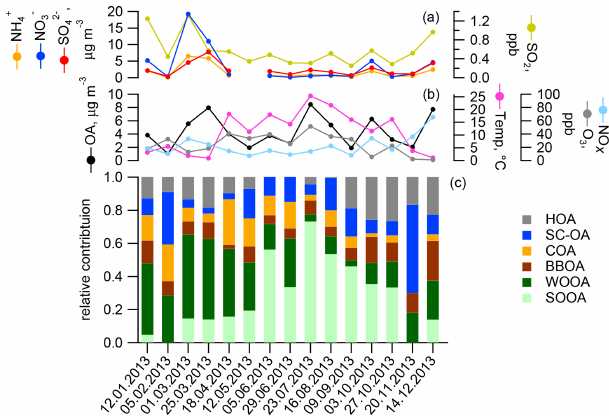
Figure 1. Concentrations of particulate and gaseous species (a, b) and relative source contributions to the organic aerosol as deter- mined by offline AMS in Zurich (c) : traffic (HOA), cooking (COA), and wood-burning POA (BBOA), as well as a factor explaining sulfur-containing organic fragments (SC-OA) and SOA categories dominant in summer (SOOA) and winter